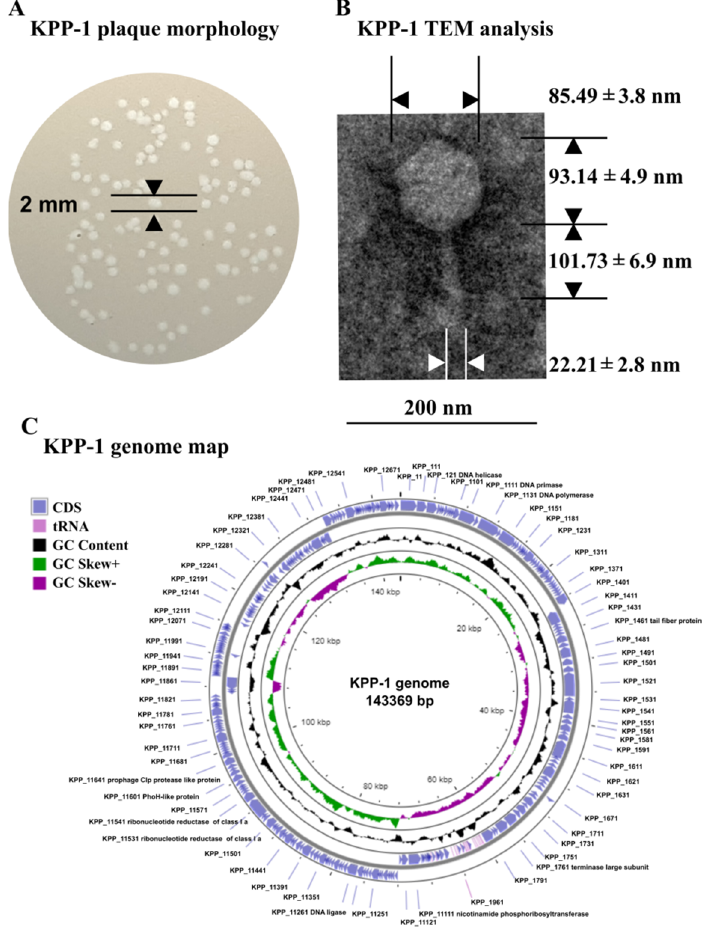
Figure 1. Morphological characterization and genome map of KPP-1. ( A ) KPP-1 creates clear plaques on lawns of K. variicola with an approximate 1–2 mm diameter. ( B ) TEM analysis of KPP-1 reveals icosahedral head and tail structures. Approximate dimensions are given in the figure (magnification: 100,000×). ( C ) Genomic map of KPP-1 demonstrates CDS, tRNA, GC content, GC skew+, and GC skew—graphs on the diagram. CDS; coding sequences.